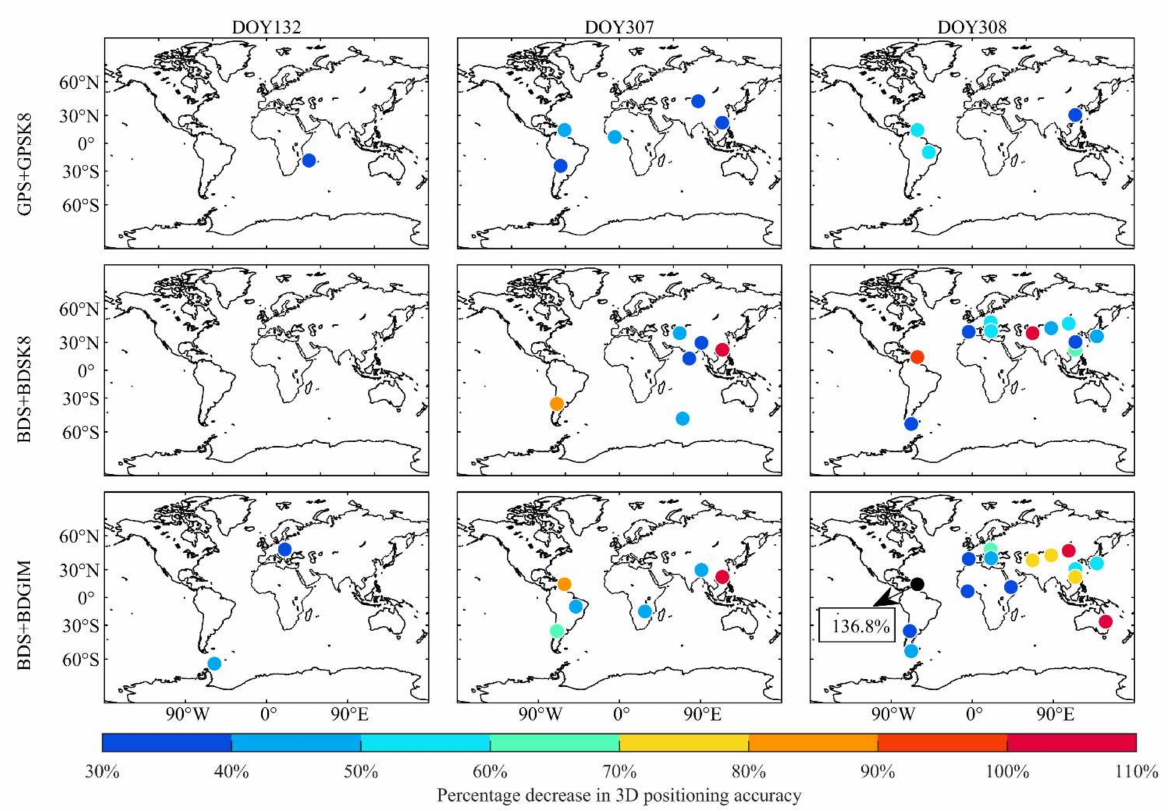
Figure 8. 3D positioning accuracy decreases in percentage during strong geomagnetic storms (only stations with more than 30% decrease in accuracy are plotted), from top to bottom three rows are GPS + GPSK8, BDS + BDSK8, and BDS + BDGIM, and from left to right three columns are the accuracy decreases of DOY 132, DOY 307 and DOY 308, it should be noted that BDS + BDSK8 does not have stations with more than 30% decrease in accuracy in DOY